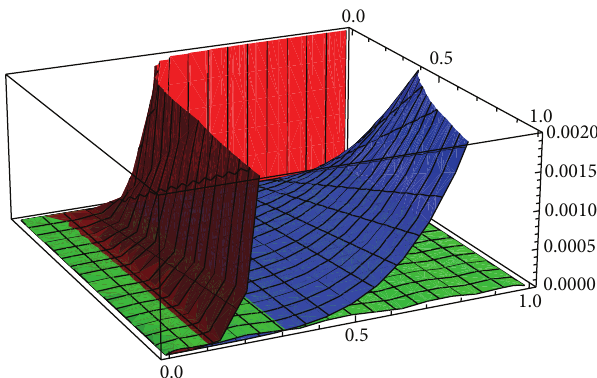
Figure 1: The absolute differences corresponding to the HPM solution (red surface), VIM solution (blue surface), and OHPM solution (green surface) for problem (16).